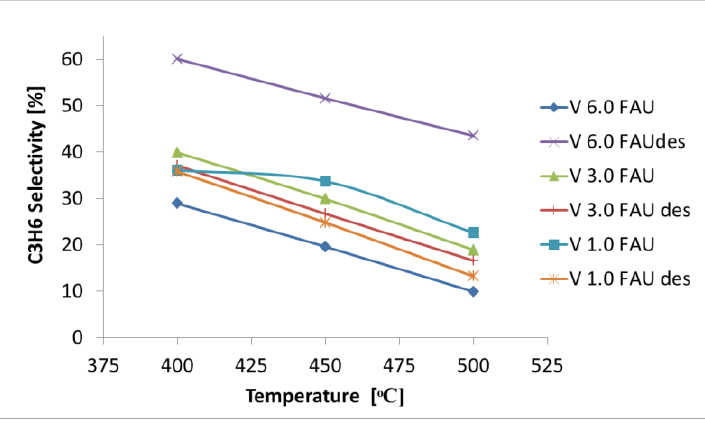
Figure 8. Selectivity to propene as a function of the reaction temperature.